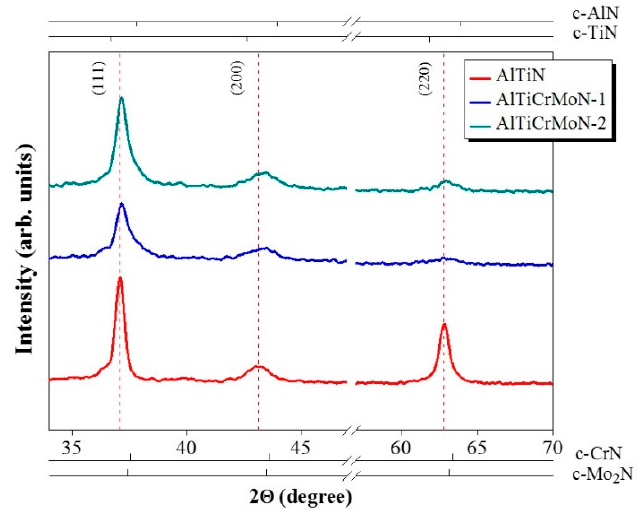
Figure 1. Glancing angle X-ray diffraction (XRD) pattern of the as-deposited AlTiN, AlTiCrMoN-1 and AlTiCrMoN-2 coatings.